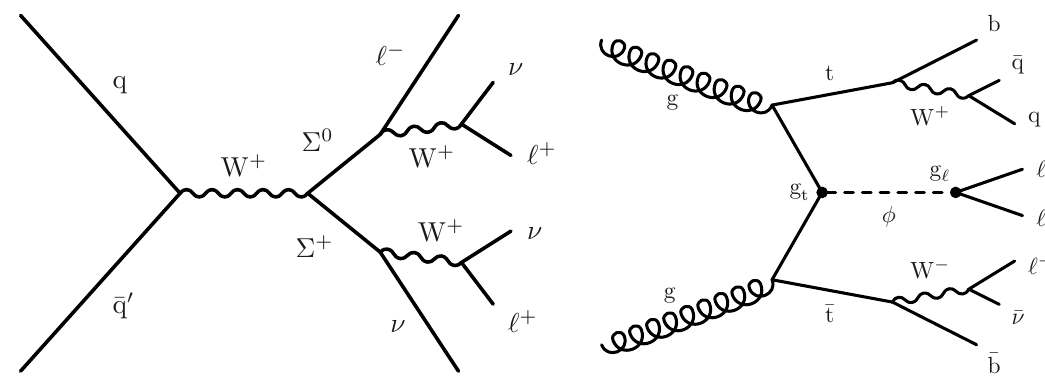
Figure 1 . Leading order Feynman diagrams for the type-III seesaw (left) and tt (cid:30) (right) signal models, depicting example production and decay modes in pp